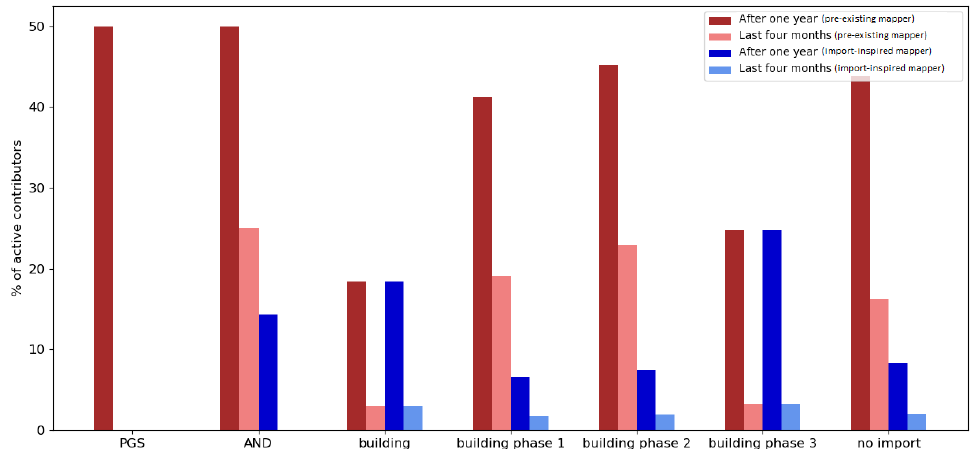
Figure 8. Ratio of contributors who participated in an import to those who remained active in